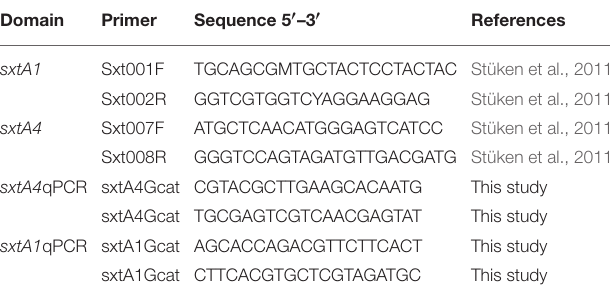
TABLE 2 | List of primers of each domain, name, sequence and the reference, were used in the study.